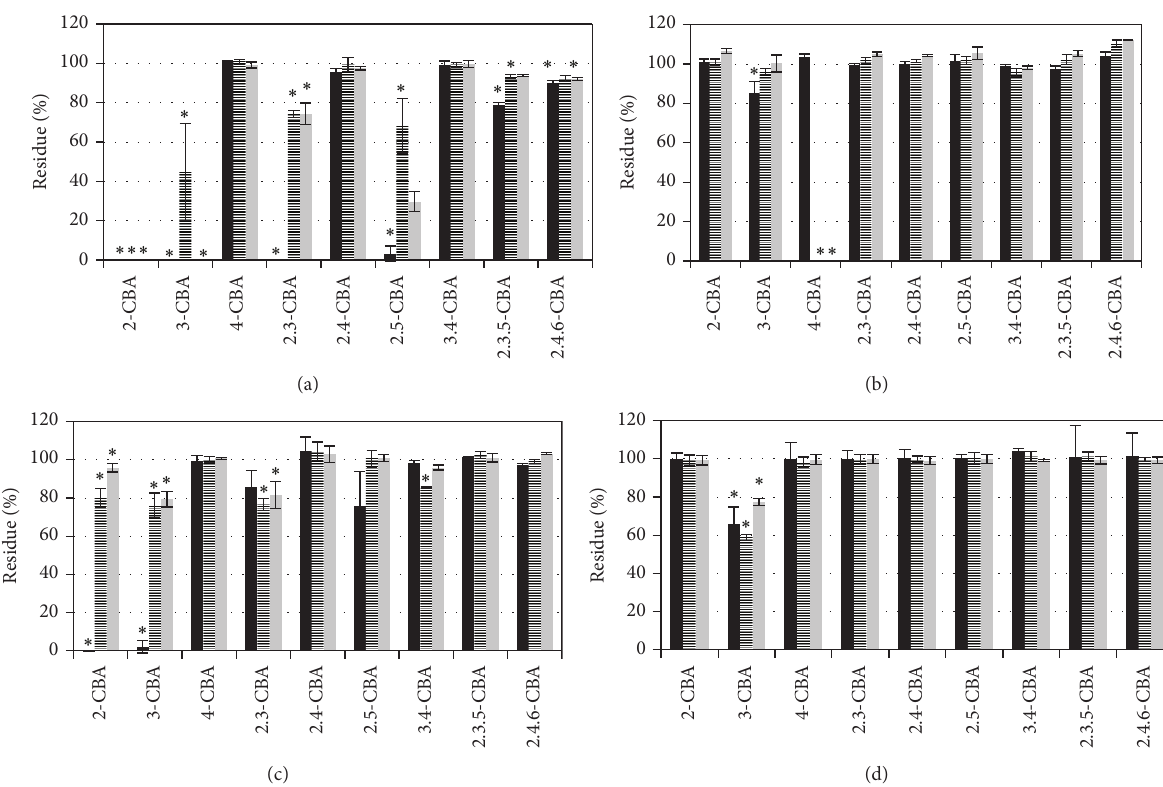
Figure 2: Degradation of single CBA ((a), (c)) and mixture of CBA ((b), (d)) by strains A18 ( Pseudomonas pseudoalcaligenes ) ((a), (b)) and A19 ( Pseudomonas stutzeri ) ((c), (d)), Black bar in minimal medium, stripped bar in minimal medium with exudates of black nightshade ( Solanum nigrum ), and grey bar in minimal medium with exudates of tobacco ( Nicotiana tabacum ). Stars indicate the statistically significant CBA removal